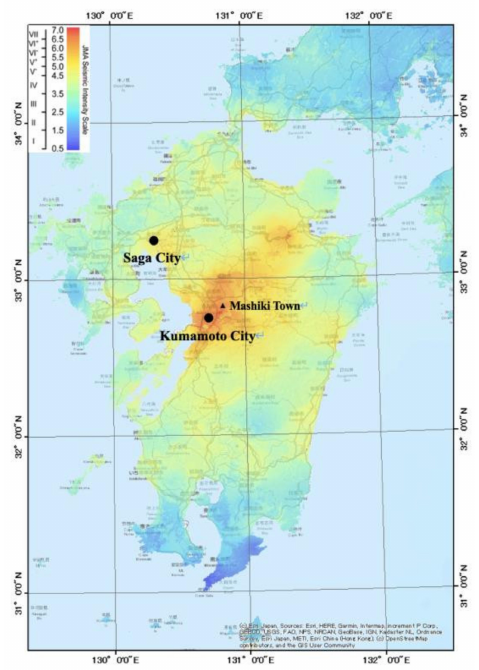
Figure 1. Distribution of the JMA seismic intensity for the mainshock of the 2016 Kumamoto earthquake